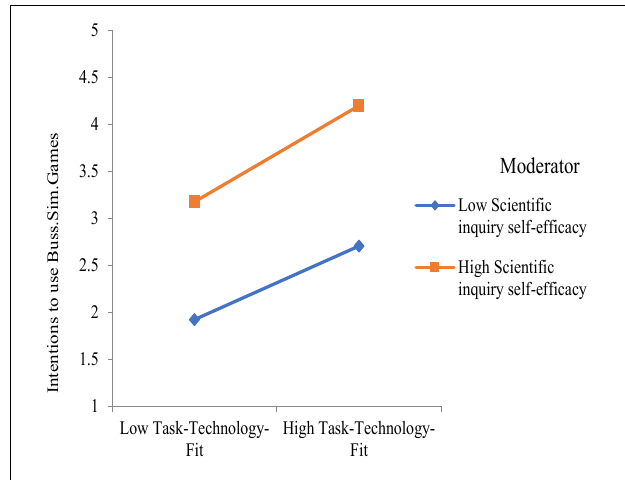
FIGURE 2 | Interaction plot for the moderating effect of the perceived simulation games self-efficacy over the relationship between the perceived TTF and the intention to use